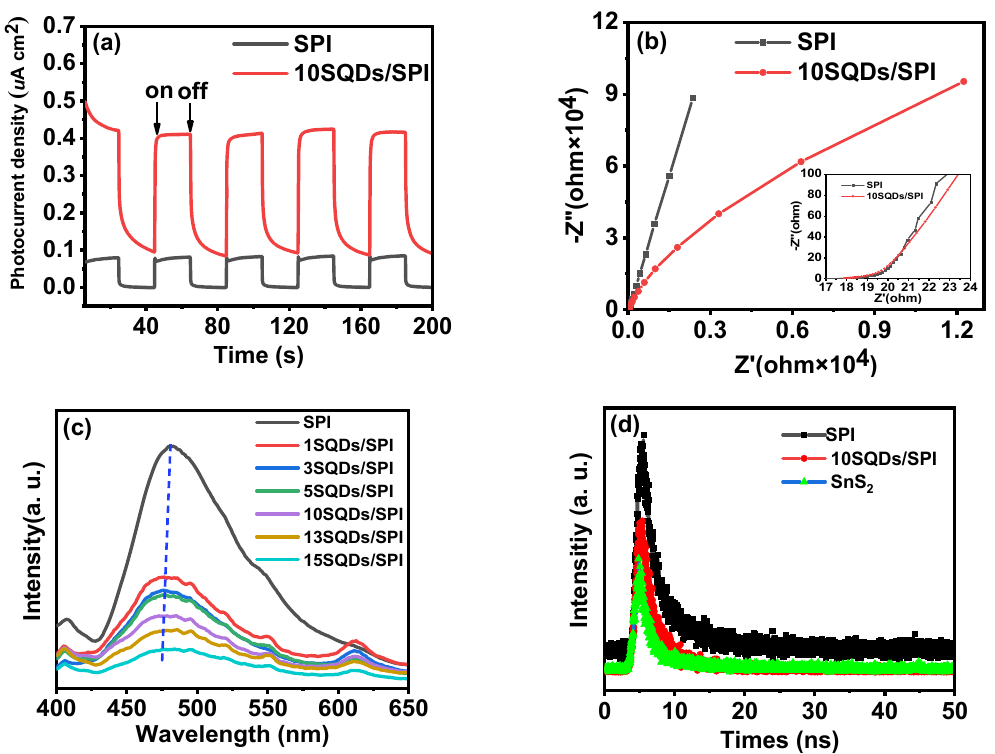
Figure 8. ( a ) Transient photocurrent response and ( b ) Nyquist plots of EIS for SPI and 10SQDs/SPI samples in 0.5 M Na 2 SO 4 aqueous solution. ( c ) Comparison of PL spectra of SPI and SQDs/SPI samples at an excitation wavelength of 425 nm. ( d ) Transient PL decay spectra for pure SPI, SQDs, and 10SQDs/SPI samples.